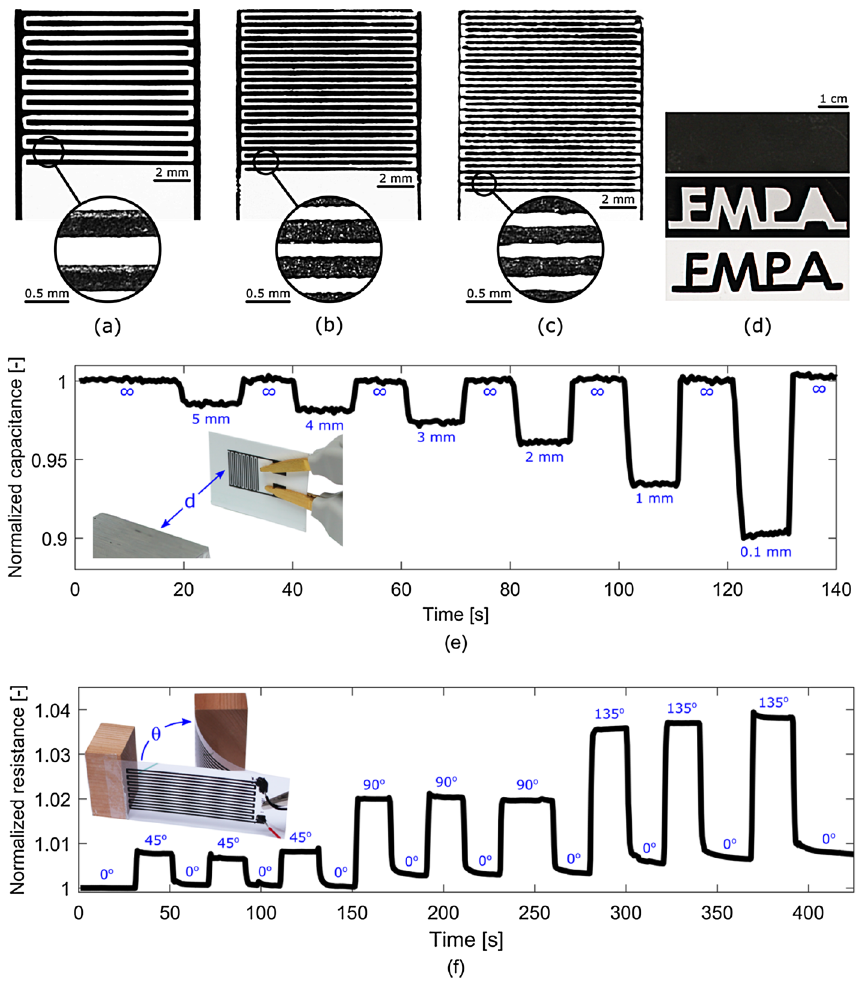
Figure 3. Photomicrographs of interdigitated electrodes patterned with our ink by (a) stencil printing, (b) screen-printing and (c) robocasting. (d) Photographs of a self-standing film of our ink (top image) laser processed to the desired geometry (middle and bottom images). (e) Graph of the normalized capacitance of interdigitated electrodes stencil-printed on paper as a function of time. The capacitance varies as a function of the distance d that separates a grounded object and the sample, acting as a proximity sensor. The object is moved from outside of the sensing range ( d = ∞) to different positions d = 5 mm, 4 mm, 3 mm, 2 mm, 1 mm and 0.5 mm. Capacitance is normalized to the value at time zero where d = ∞. (f) Graph of the normalized resistance of a meander resistor stencil-printed on polyethylene terephthalate (PET) as a function of time. The resistance varies as a function of the deflection angle θ of the single-clamped sample, acting as a deformation sensor. The sample is deformed from its rest position (θ = 0°) to different deflection angles θ = 45°, 90° and 135°. Resistance is normalized to the value at time zero where θ =